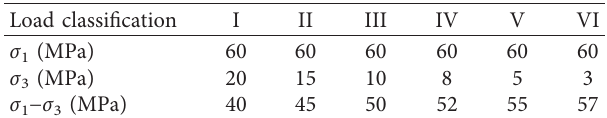
Table 3: Unloading confining pressures with constant axial pressure triaxial test